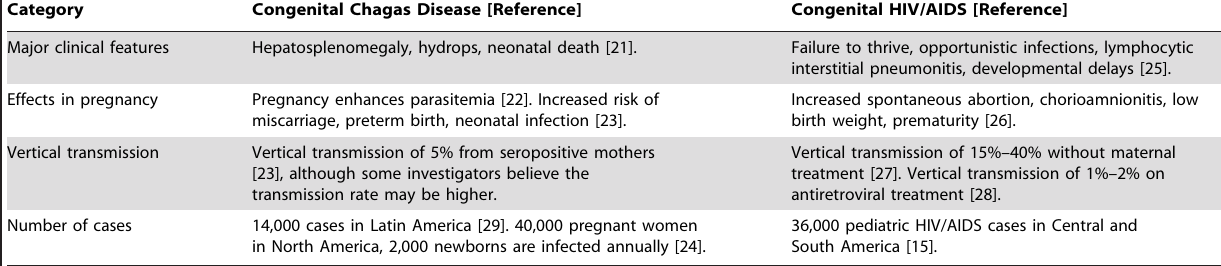
Table 2. Comparison of congenital Chagas disease and